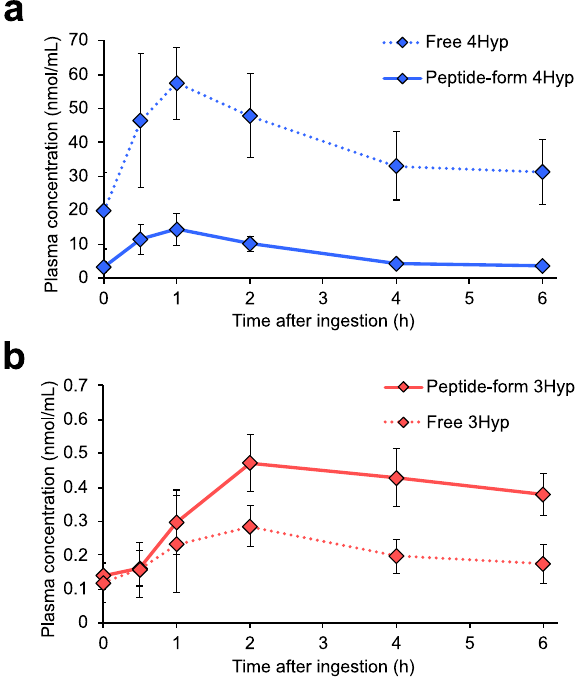
Fig. 1 Concentrations of free and peptide-form Hyp in human plasma after oral ingestion of collagen hydrolysate. Human plasma samples collected before (0 h) and 0.5, 1, 2, 4, and 6 h after the ingestion of porcine skin collagen hydrolysate were analyzed by LC − MS in MRM mode with (total Hyp) or without (free Hyp) acid hydrolysis. Peptide-form Hyp was quantitated by subtracting the quantitative values of free Hyp from total Hyp. a 4Hyp and b 3Hyp were separately analyzed by APDS derivatization. The data represent the mean ± SD ( n =